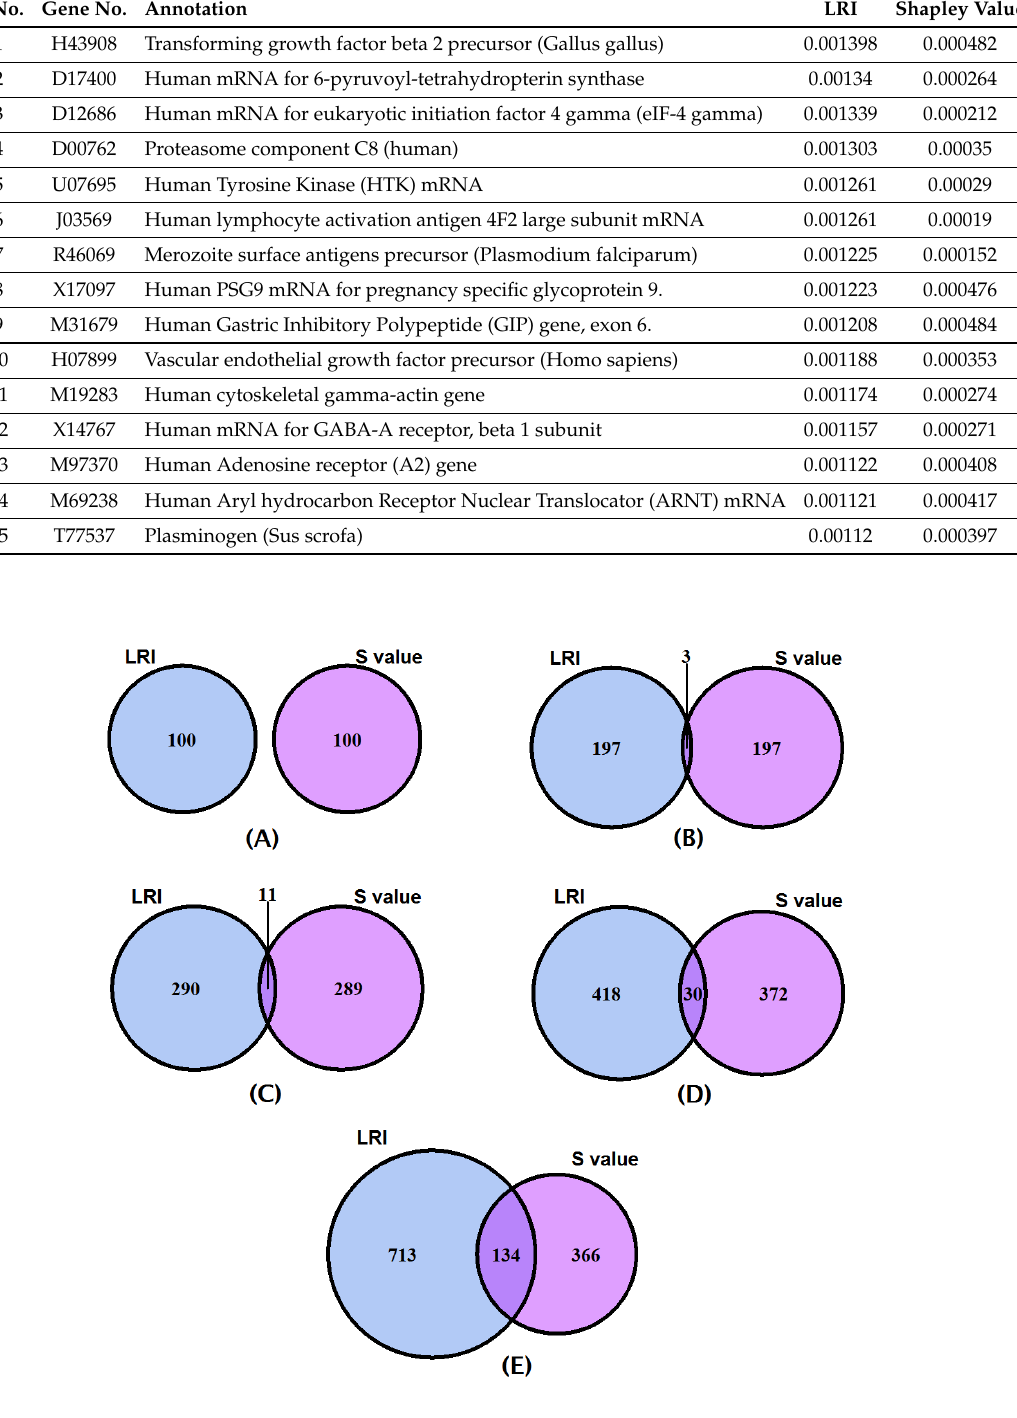
Figure 2. Venn diagrams exhibiting overlaps between the top 100 ( A ), 200 ( B ), 300 ( C ), 400 ( D ), and 500 ( E ) ranked gene sets identified by the LRI (cornflower blue) and Shapley (S) (dark orchid)